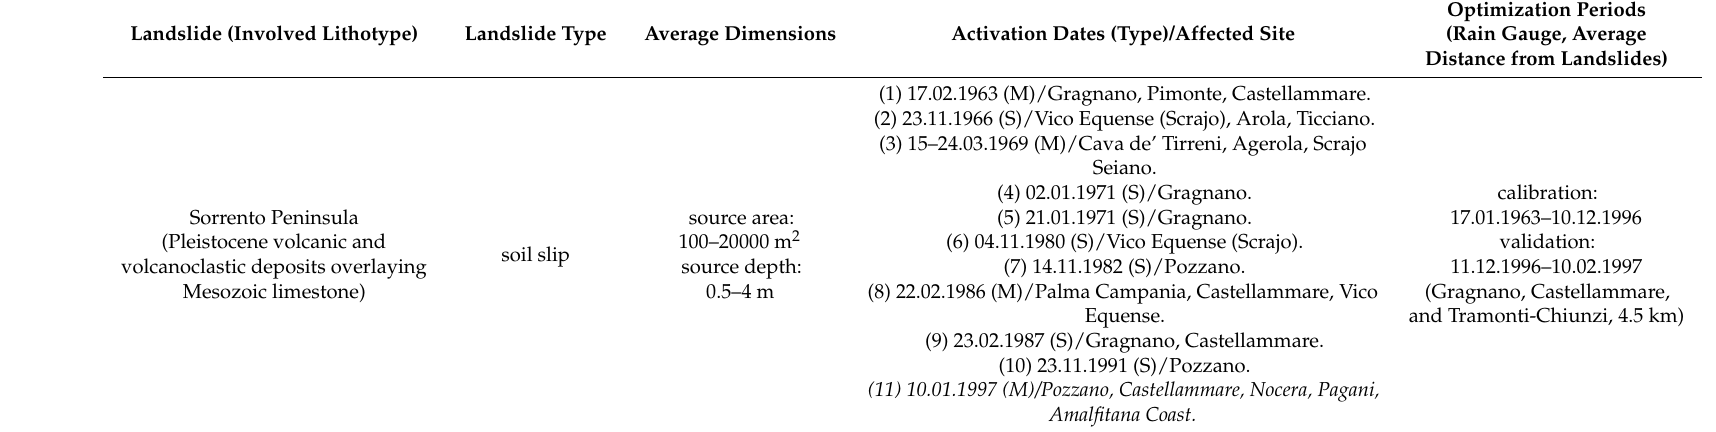
Table 3. Main characteristics of the considered Campanian case studies. Key: (M) multiple activation; (S) single activation. In Italics, the date of activation used for validation. Employed data series range from the beginning of the calibration periods to the end of the validation period (cf. last column). The Gragnano rain gauge was employed for the Campanian cases. Missing values (about 2% of the whole set) were taken from the Castellammare and Tramonti-Chiunzi